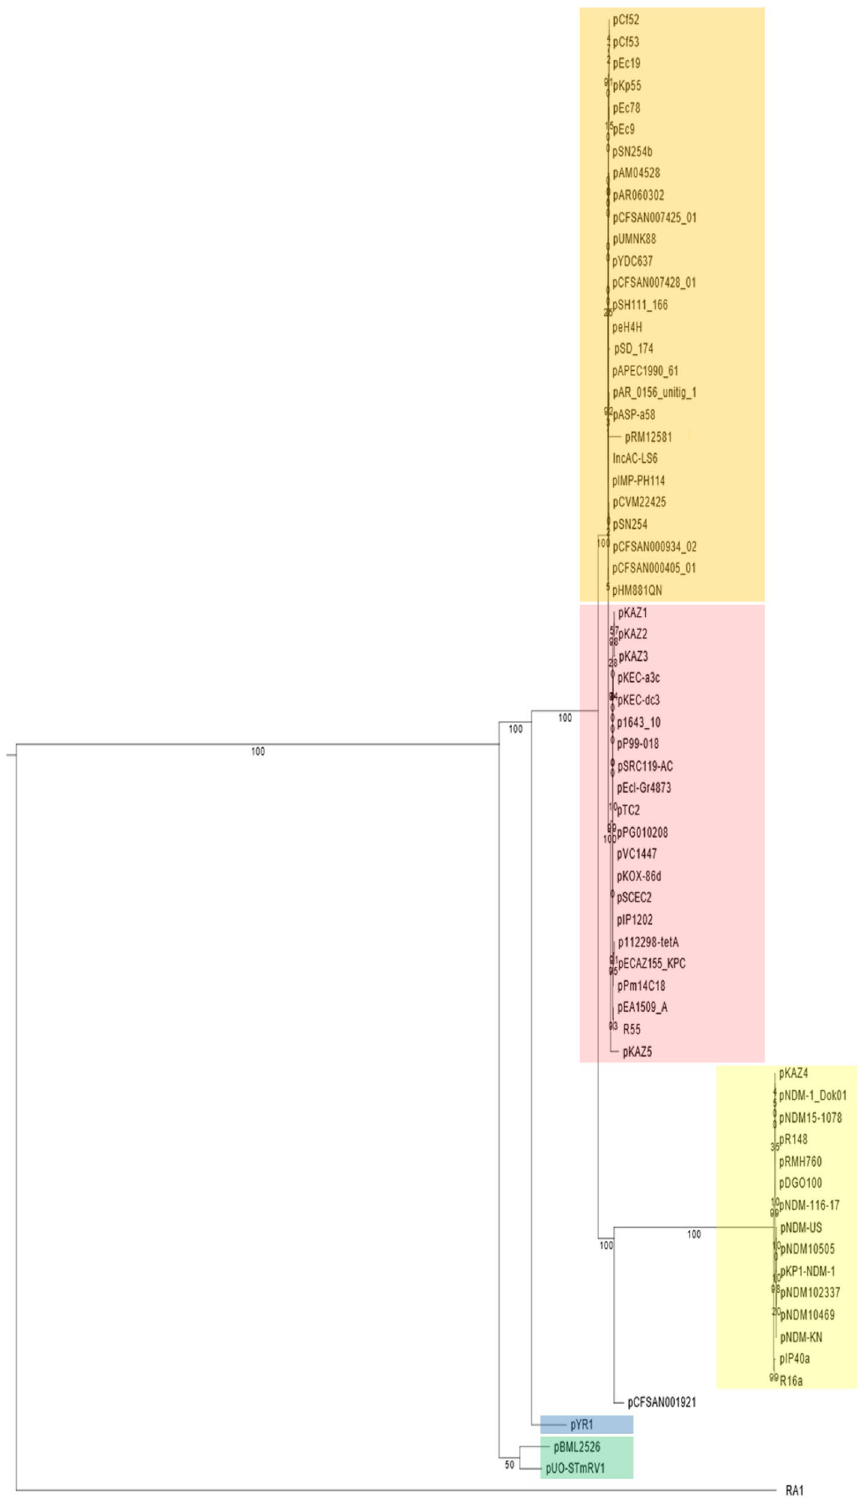
Figure 3. Phylogenetic relationships of pUO-STmRV1. The nucleotide sequences of 67 IncC plasmids and of RA1 (IncA) were extracted from GenBank-NCBI (Table S1). The tree was based on a 17,713 ± 37 bp core genome including 28 orthologous common genes (Table S2) with at least 80% identity and 80% coverage, using 100 bootstrapping replicates. IncC types and subtypes are highlighted in yellow, type 1a; orange, type 1b; pink, type 2; blue, pYR1; green, pUO-STmRV1 and pBML2526. As shown in the pairwise SNP distance matrix used to build the tree (Table S3), the number of SNP separating pUO-STmRV1 from pBML2526, pYR1, pR148 (type 1a), pSN254 (type 1b) and R55 (type 2), which are all IncC, and from the IncA plasmid RA1 are 78, 143, 410, 212, 215 and 1,336,